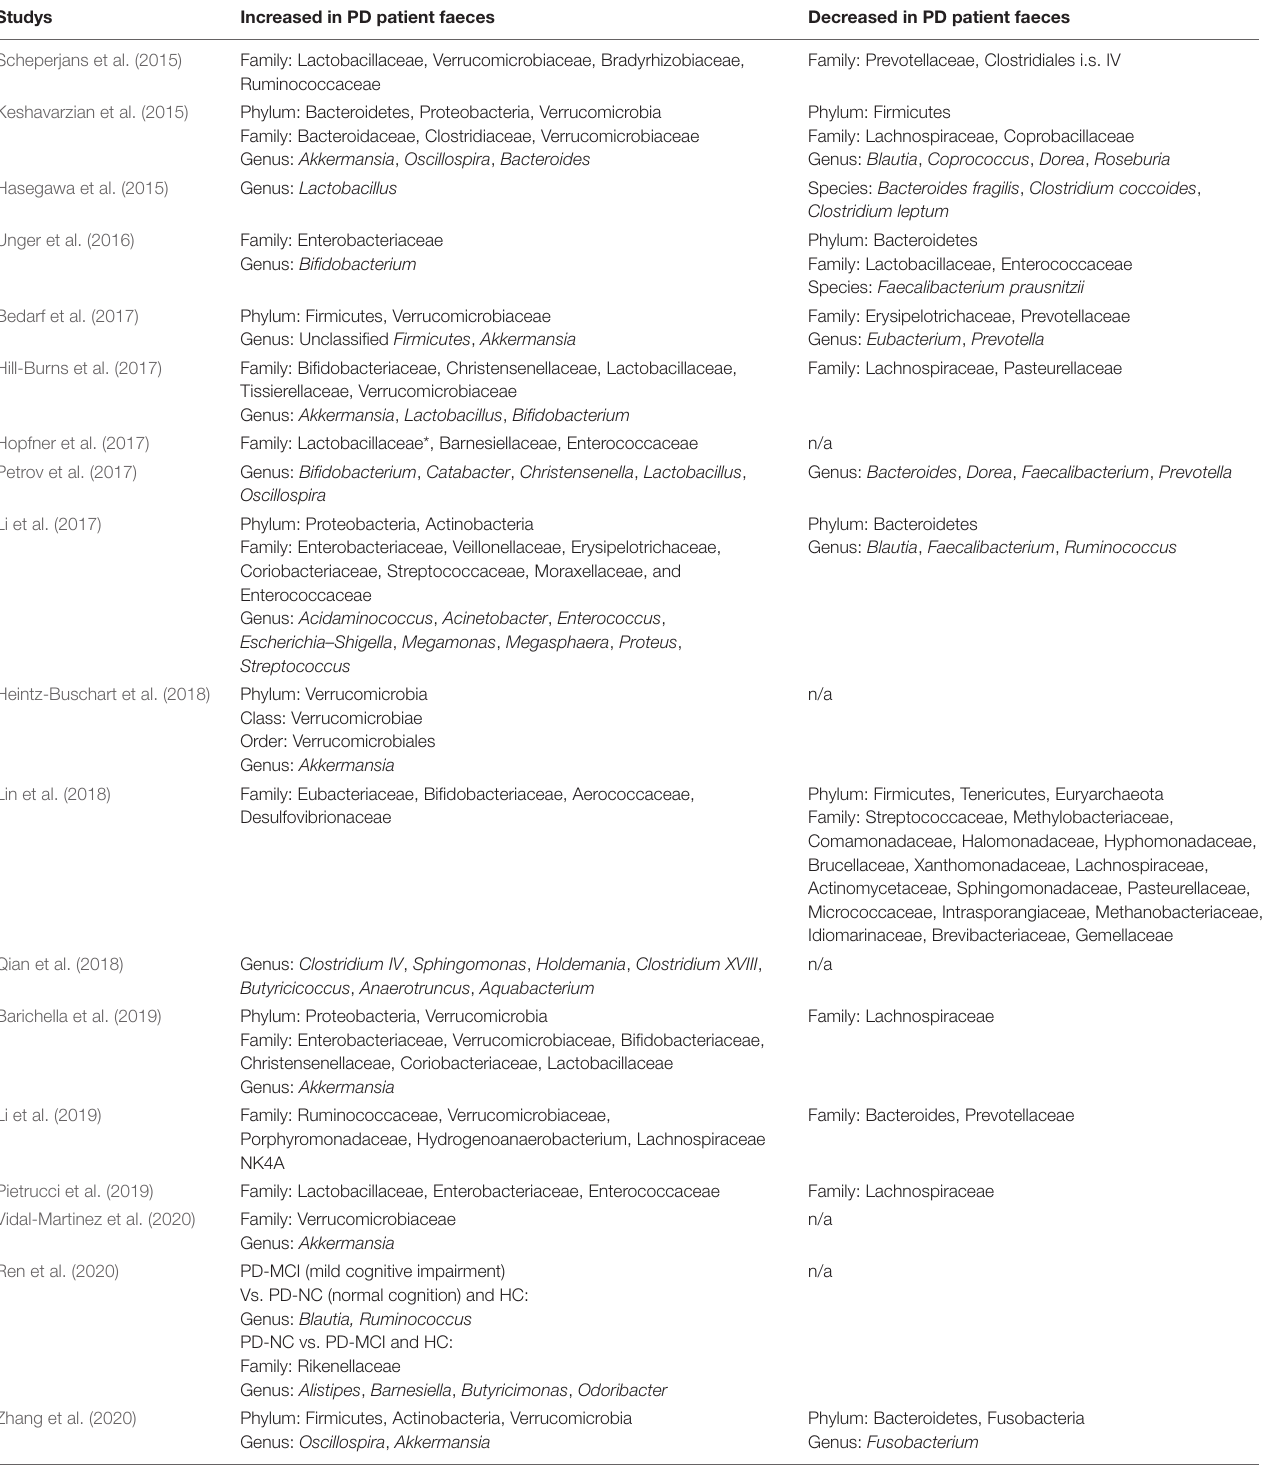
TABLE 1 | Table presenting results of statistically significant ( p < 0.05) changes in abundance of bacterial taxa in faecal samples between Parkinson’s disease patients (PD) and healthy controls (HCs). Studys Increased in PD patient